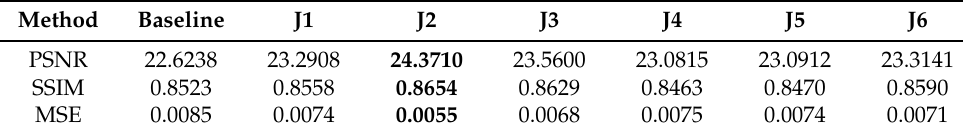
Table 2. Comparison of test metrics with different module